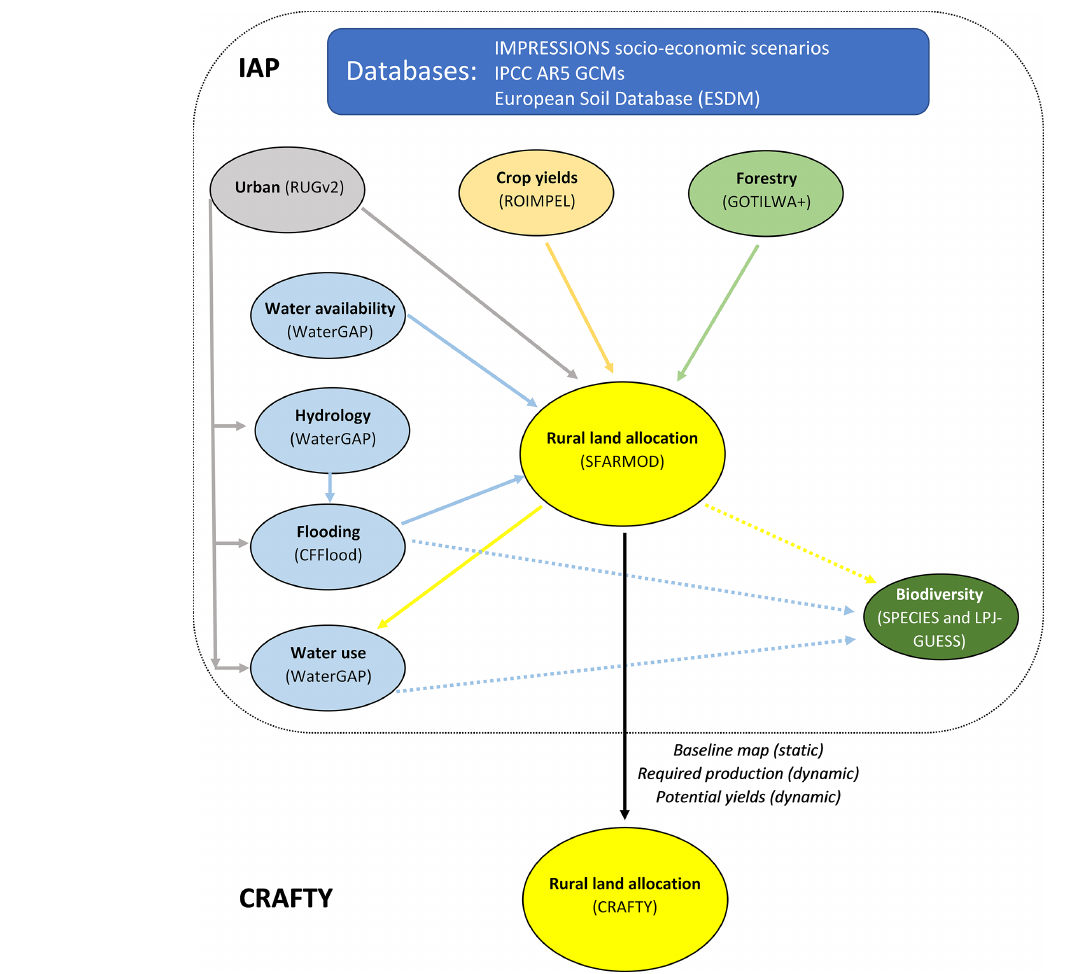
Figure 1. Simplified schema showing the structure of the IAP in terms of its component meta-models and its relationship to CRAFTY in this study. Results presented in this study are taken from the alternative land allocation models (yellow), and results from the biodiversity model are not used. The information transferred from the IAP to CRAFTY utilises all of the inputs to SFARMOD and describes initial and scenario-dependent conditions affecting agent decision-making in